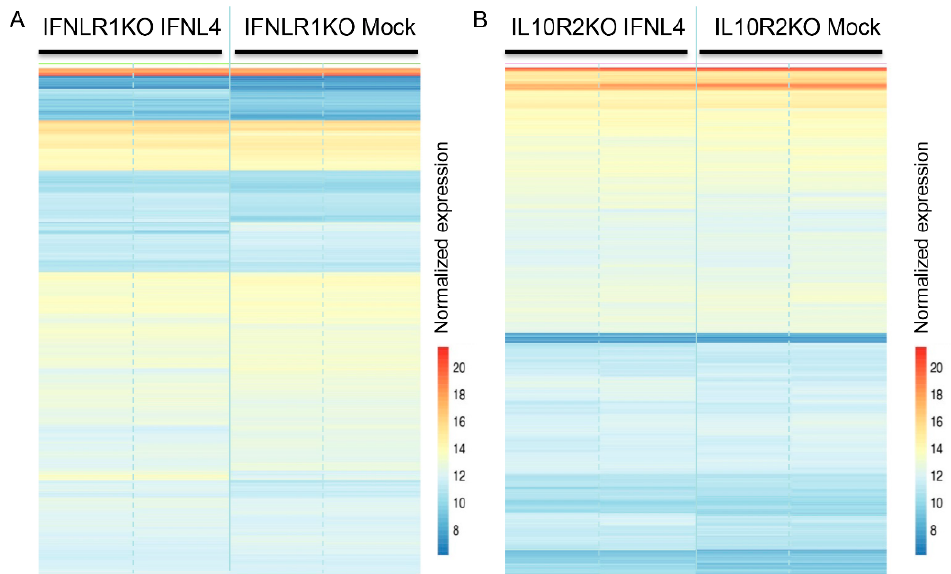
Figure 7. Gene expression profiles of IFNLR1 and IL10R2 KO cells transfected with IFNL4. Heat map of 1000 most expressed genes determined by RNAseq analysis of IFNLR1 − / − ( A ) and IL10R2 − / − ( B ) HuH7 cells transfected with non-tagged IFNL4 for 48 h. Empty plasmid was used as a mock control. Two biological replicates were used per each group. Color represents gene expression from blue (downregulated) to red (upregulated). Fragment counts were normalized using the variance stabilizing transformation.